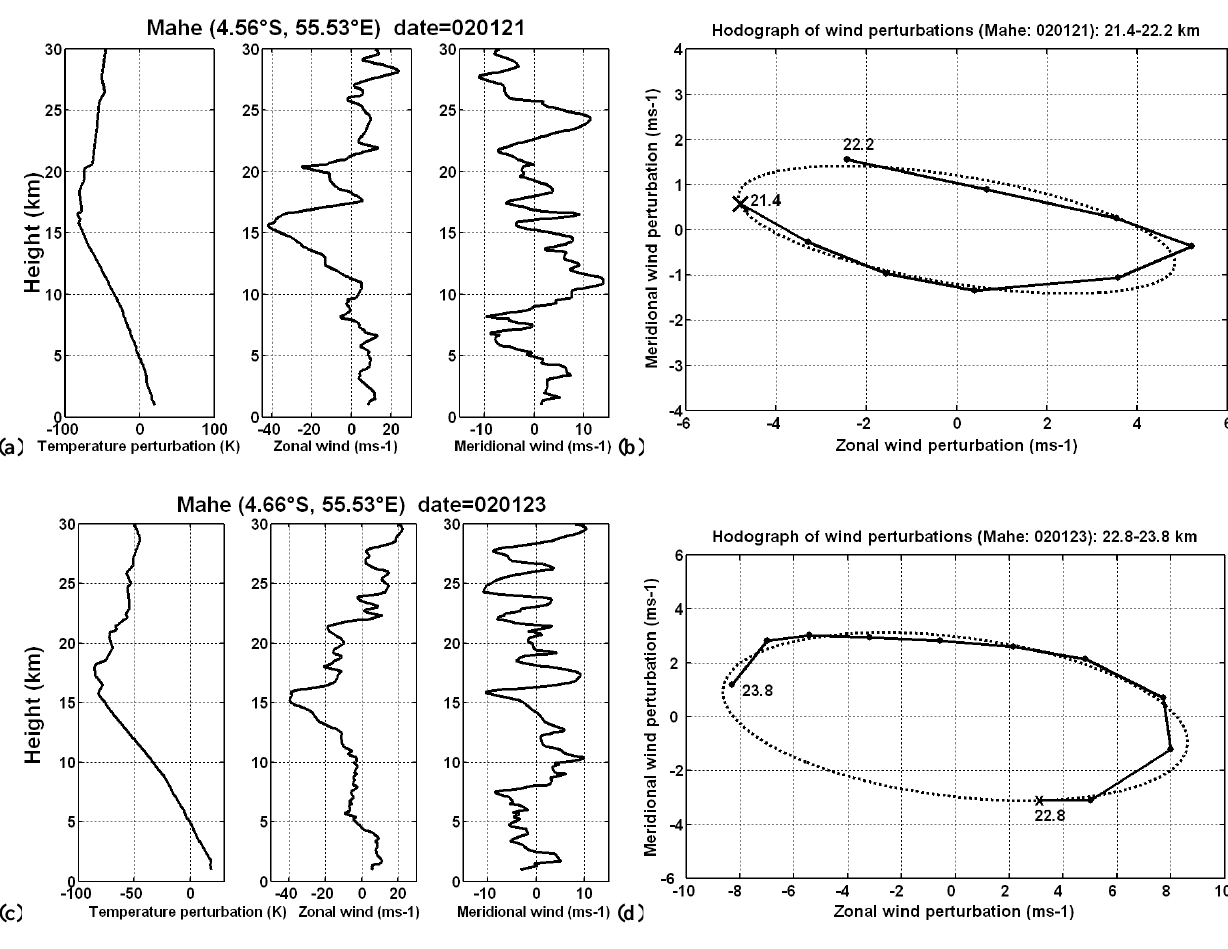
Fig. 4. Same as Fig. 3 but at Mahe.